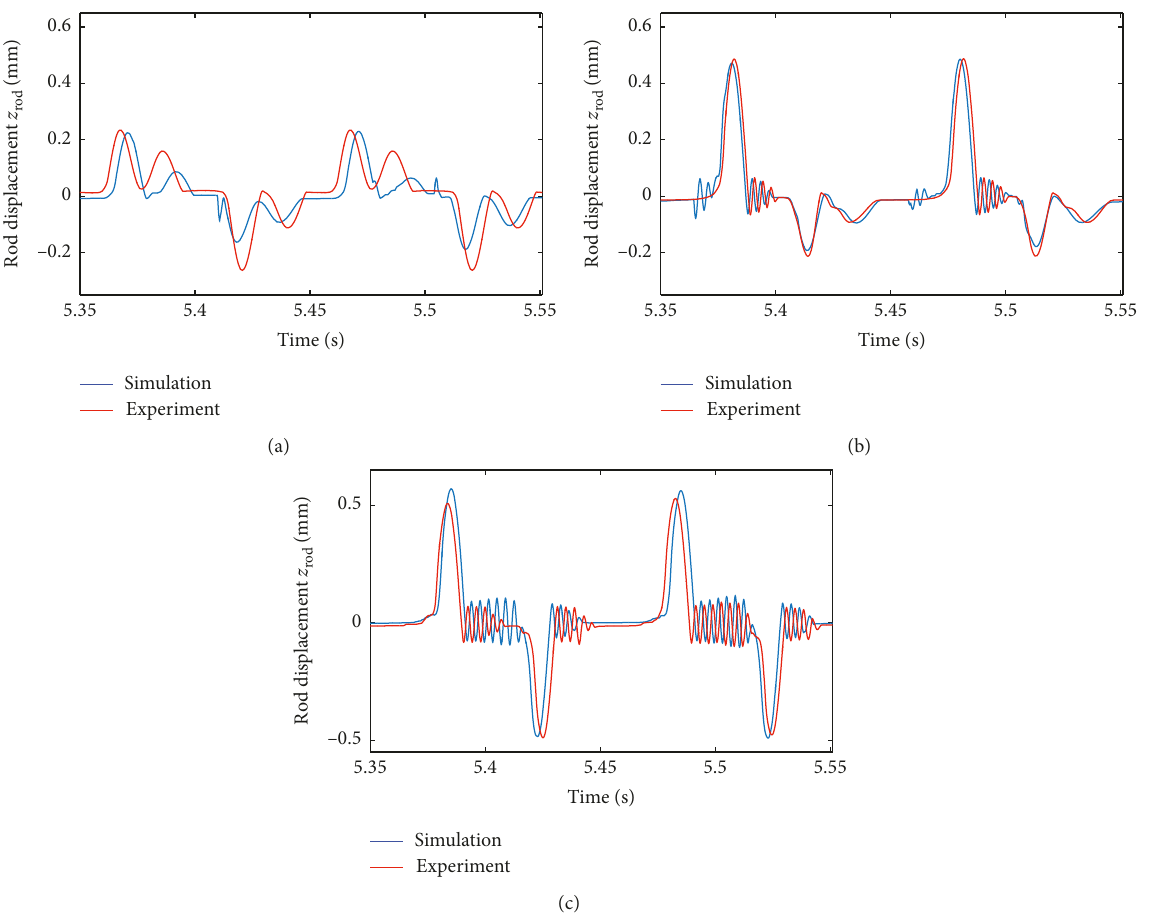
Figure 29: Displacements z